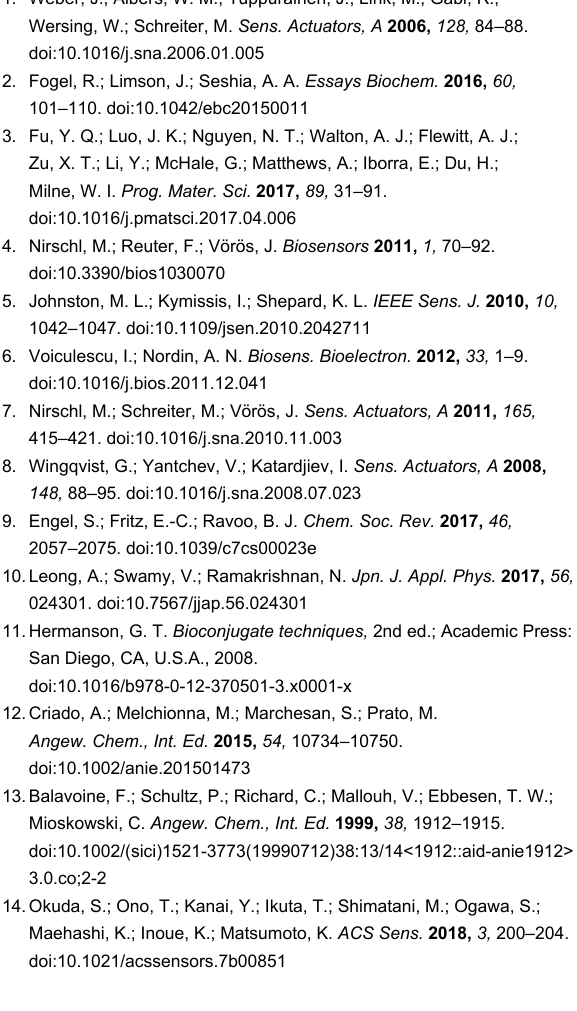
Figure 10: Experimental setup for bio-detection: sketch of the fluidic system and photos of the experimental